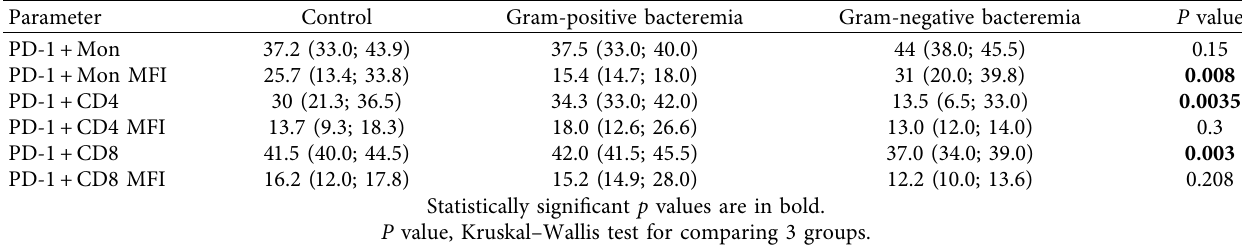
Table 5: PD-1 on lymphocytes and monocytes.